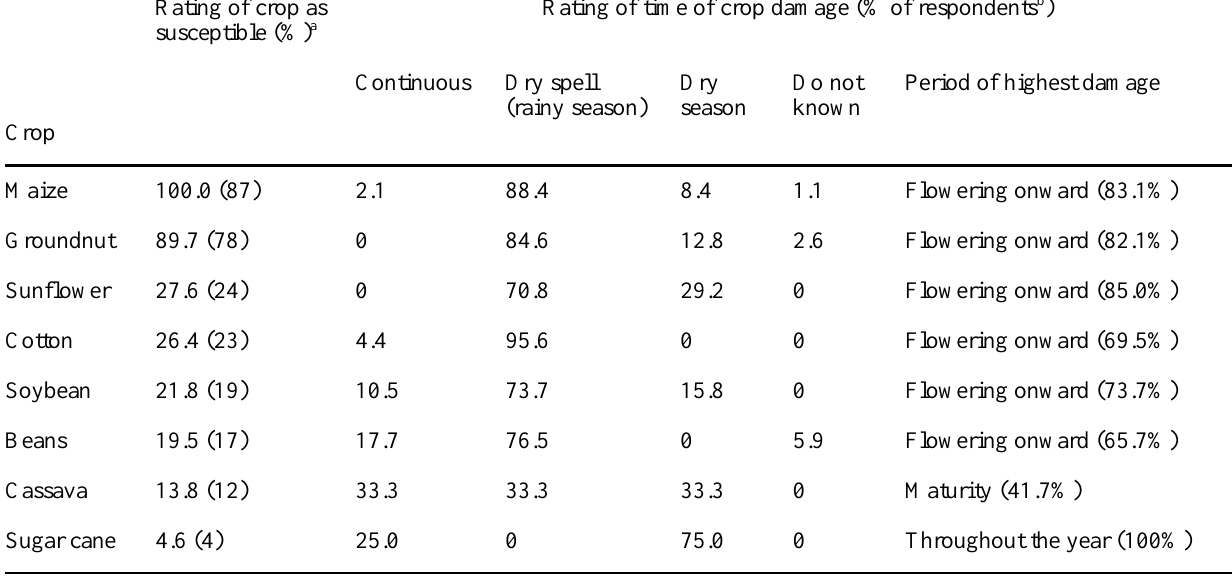
Table 3. Farmers’ perception of susceptibility of crops to termite damage and time of crop damage in eastern Zambia (source: Sileshi, unpublished data) Rating of crop as Rating of time of crop damage (% of respondents b ) susceptible (%) a Continuous Dry spell Dry Do not Period of highest damage (rainy season) season known 100.0 (87) 2.1 88.4 8.4 1.1 Flowering onward (83.1%) Groundnut 89.7 (78) 0 84.6 12.8 2.6 Flowering onward (82.1%) 27.6 (24) 0 70.8 29.2 0 Flowering onward (85.0%) Cotton 26.4 (23) 4.4 95.6 0 0 Flowering onward (69.5%) 21.8 (19) 10.5 73.7 15.8 0 Flowering onward (73.7%) 19.5 (17) 17.7 76.5 0 5.9 Flowering onward (65.7%) 13.8 (12) 33.3 33.3 33.3 0 Maturity (41.7%) 4.6 (4) 25.0 0 75.0 0 Throughout the year